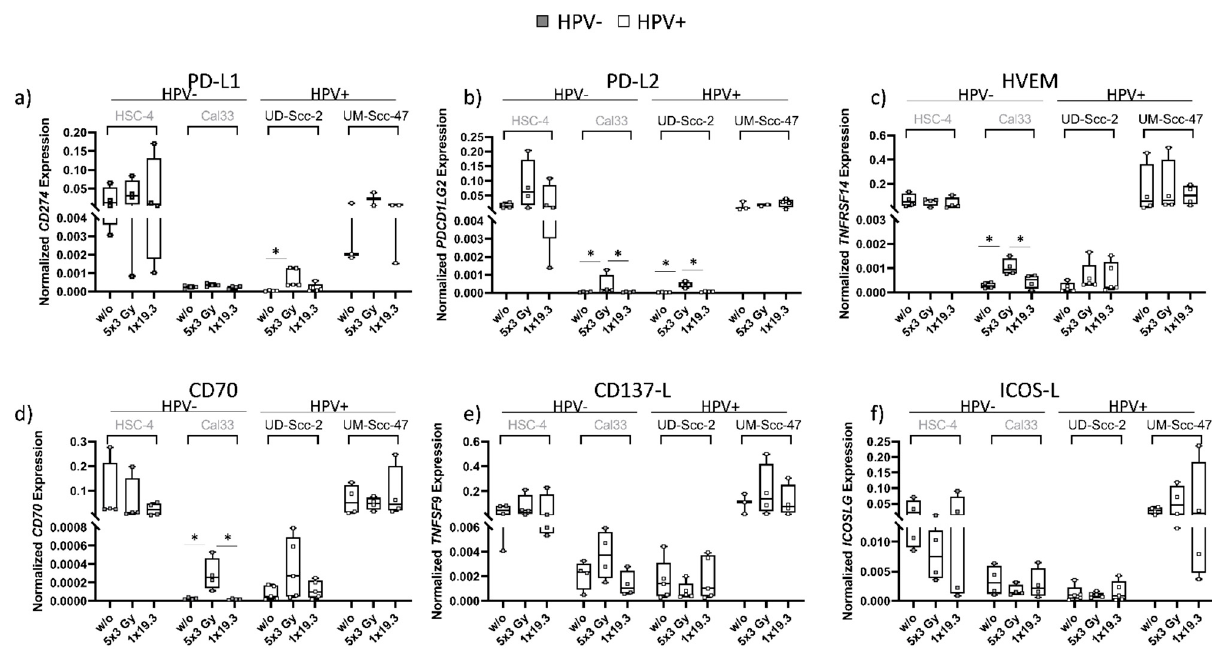
Figure 4. Normalized gene expression of immune suppressive (PD-L1 ( a ), PD-L2 ( b ), HVEM ( c ) and immune stimulatory (CD70 ( d ), CD137-L ( e ), ICOS-L ( f )) checkpoint molecules of HPV-negative (grey dots) and HPV-positive (white dots) HNSCC cell lines. Cells were subjected to either a hypofractionated irradiation regimen (5x3.0Gy) or a single high dose of 19.3Gy. Normalized gene expression was calculated by normalizing samples to the following housekeeping genes: HPV − : ACTB, RPL27, RPL30, RPS18; HPV+: ACTB, RPL27, RPL30, RPS18, UBC. Graphs show Median + min to max for n HSC-4 = 4, n Cal33 = 5, n UD-Scc-2 = 5, n UM-Scc-47 = 3 biological independent experiments and a two-sided Mann–Whitney U test was performed for comparisons of treatments within one cell line: * p < 0.05.